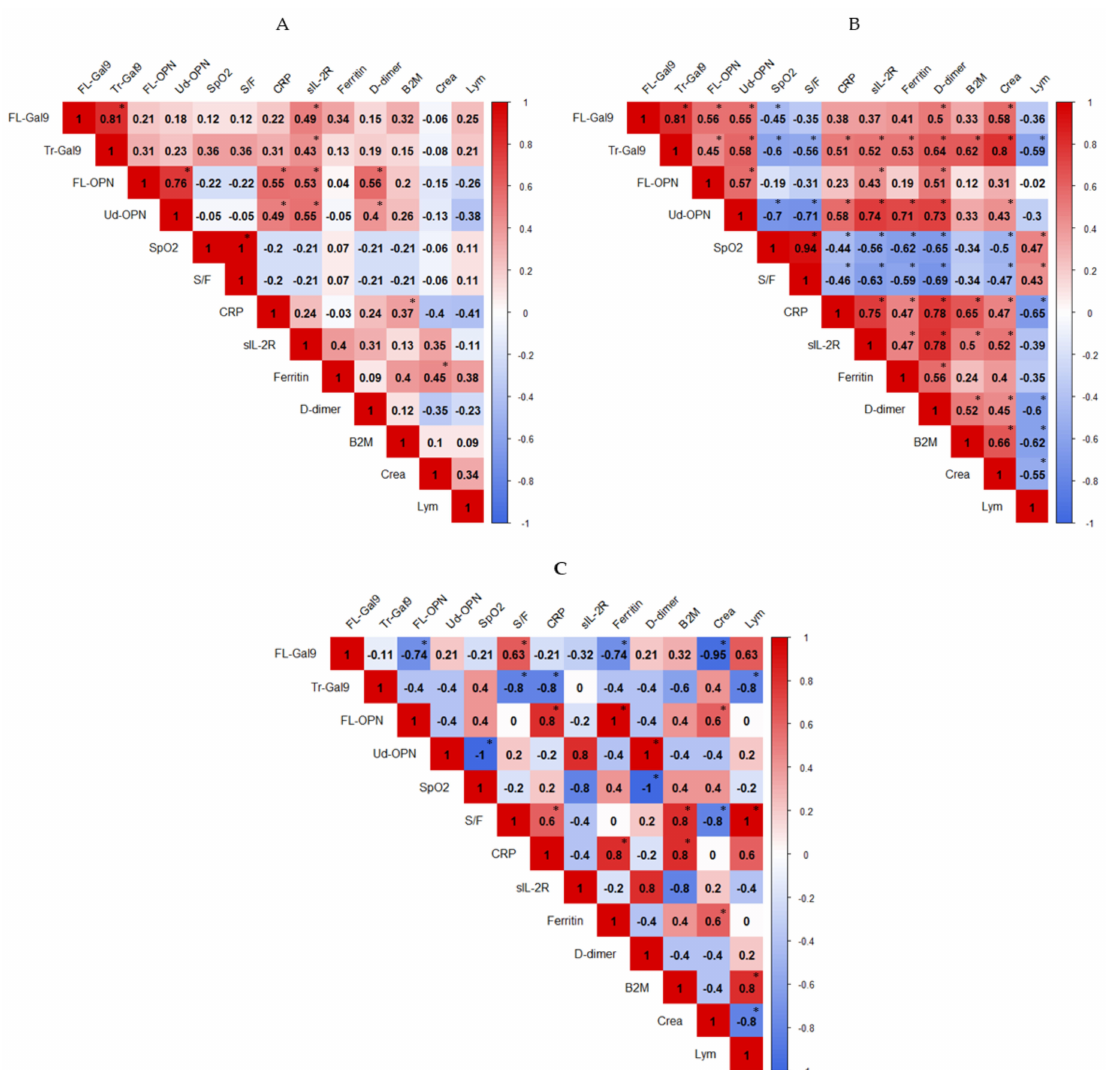
Figure 6. Associations of studied indicators in the CV ( A ), CP ( B ), and ID ( C ) groups. The correlation was measured by the Spearman t -test. The correlation R-value is written in each well and displayed as colors ranging from blue to red as shown in the legend key. p -value is written significant as * p <